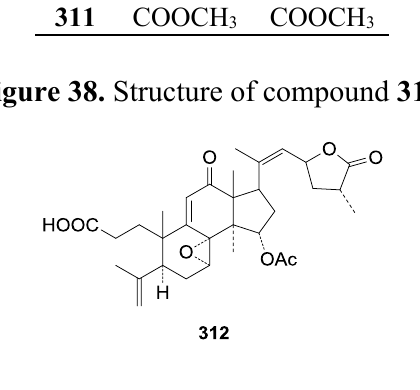
Figure 39. Structures of compounds 313 – 315